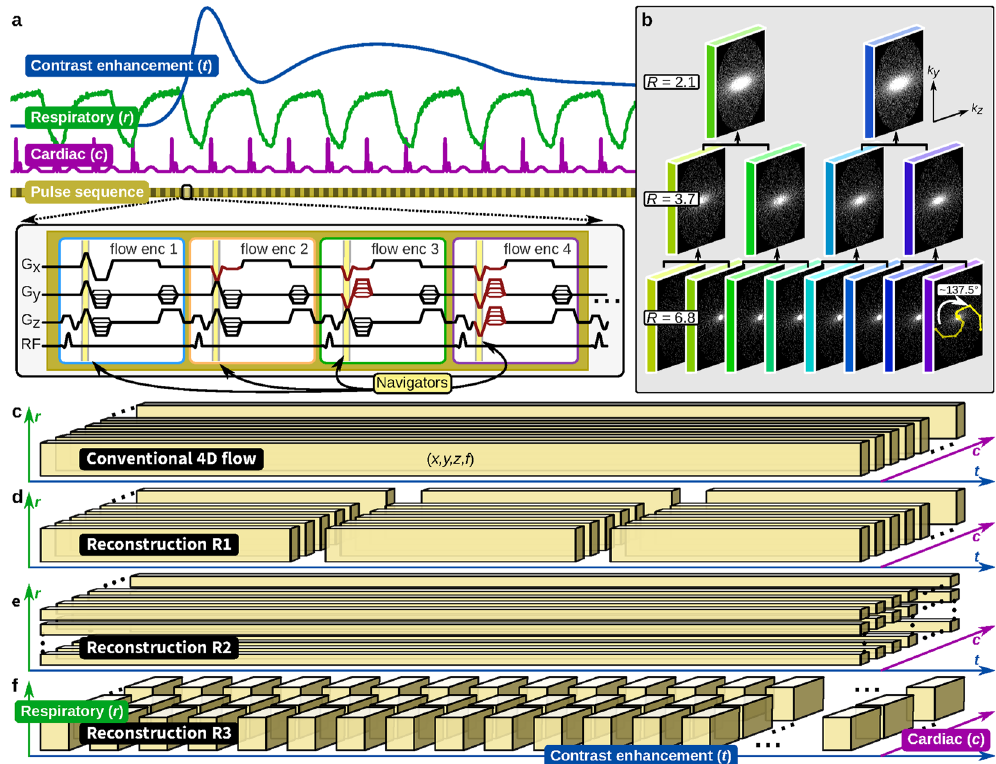
Figure 1. Data acquisition overview. ( a ) Pulse sequence diagram. ( b ) Cartesian sampling masks generated using the variable-density and radial view-ordering (VDRad) design. ( c – f ) Single dataset acquired in the multi- dimensional space reconstructed with different methods of data binning where each data block consists of three-dimensional spatial ( x , y , z ) and flow encoding ( f ). In ( a ) different dimensions are illustrated: dynamic contrast enhancement ( t ), respiratory phase ( r ), and cardiac phase ( c ). For volumetric flow quantification, four different flow-encoding gradients are used to sensitize the acquisition to four different velocities. The flow-encoding gradients provide the setup to intrinsically measure motion using Butterfly navigators. In ( b ) VDRad determines the order in which each ( k y , k z )-sample is collected using the golden-ratio angle increment (~137.5°). The same samples can be divided into different number of sampling masks where fewer masks correspond to lower subsampling reduction factors (from R of 6.8 to 2.1). This property is important for retrospective binning of the data. The variable-density sampling provides ideal source data for compressed sensing reconstructions. Conventional 4D flow depicted in ( c ) ignores the r , c , and t dimensions. XD flow extends this same single dataset into higher-dimensional-space for highlighting different clinical indications. Three different examples of this flexibility is illustrated in ( d – f ).